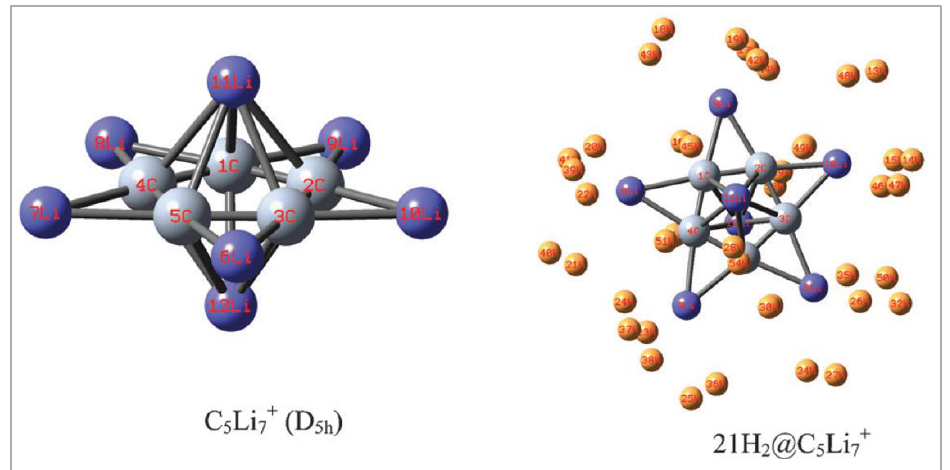
Figure 4. C 5 Li 7+ and 21 H 2 @C 5 Li 7+ at the M06/6-311+G(d,p) level. This figure is reproduced from Reference [19].